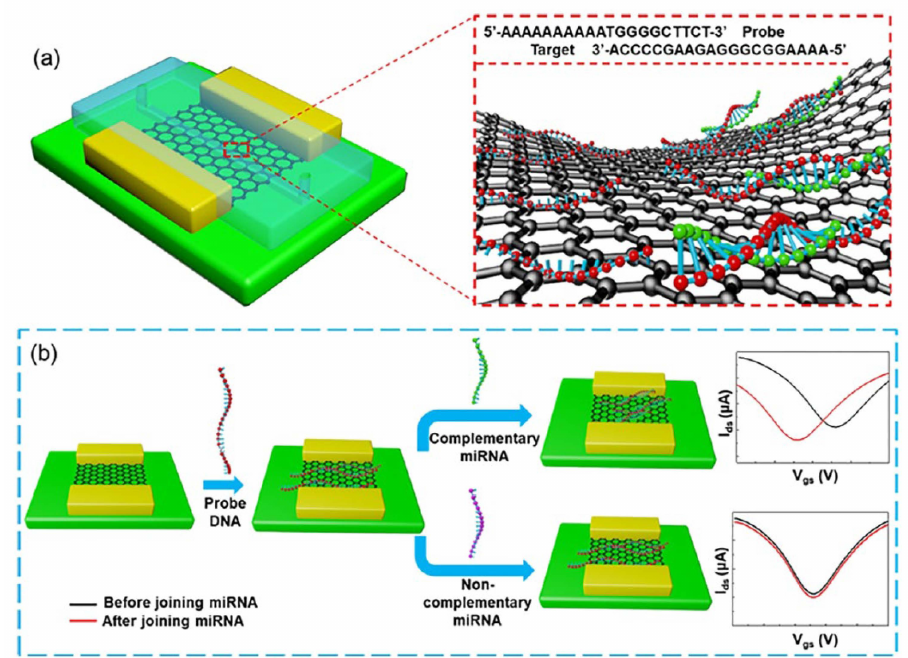
Figure 14. ( a ) The surface structure and ( b ) the detection principle of the miRNA FET biosensor. Reprinted with permission from Ref. [108]. Copyright 2020, American Chemical